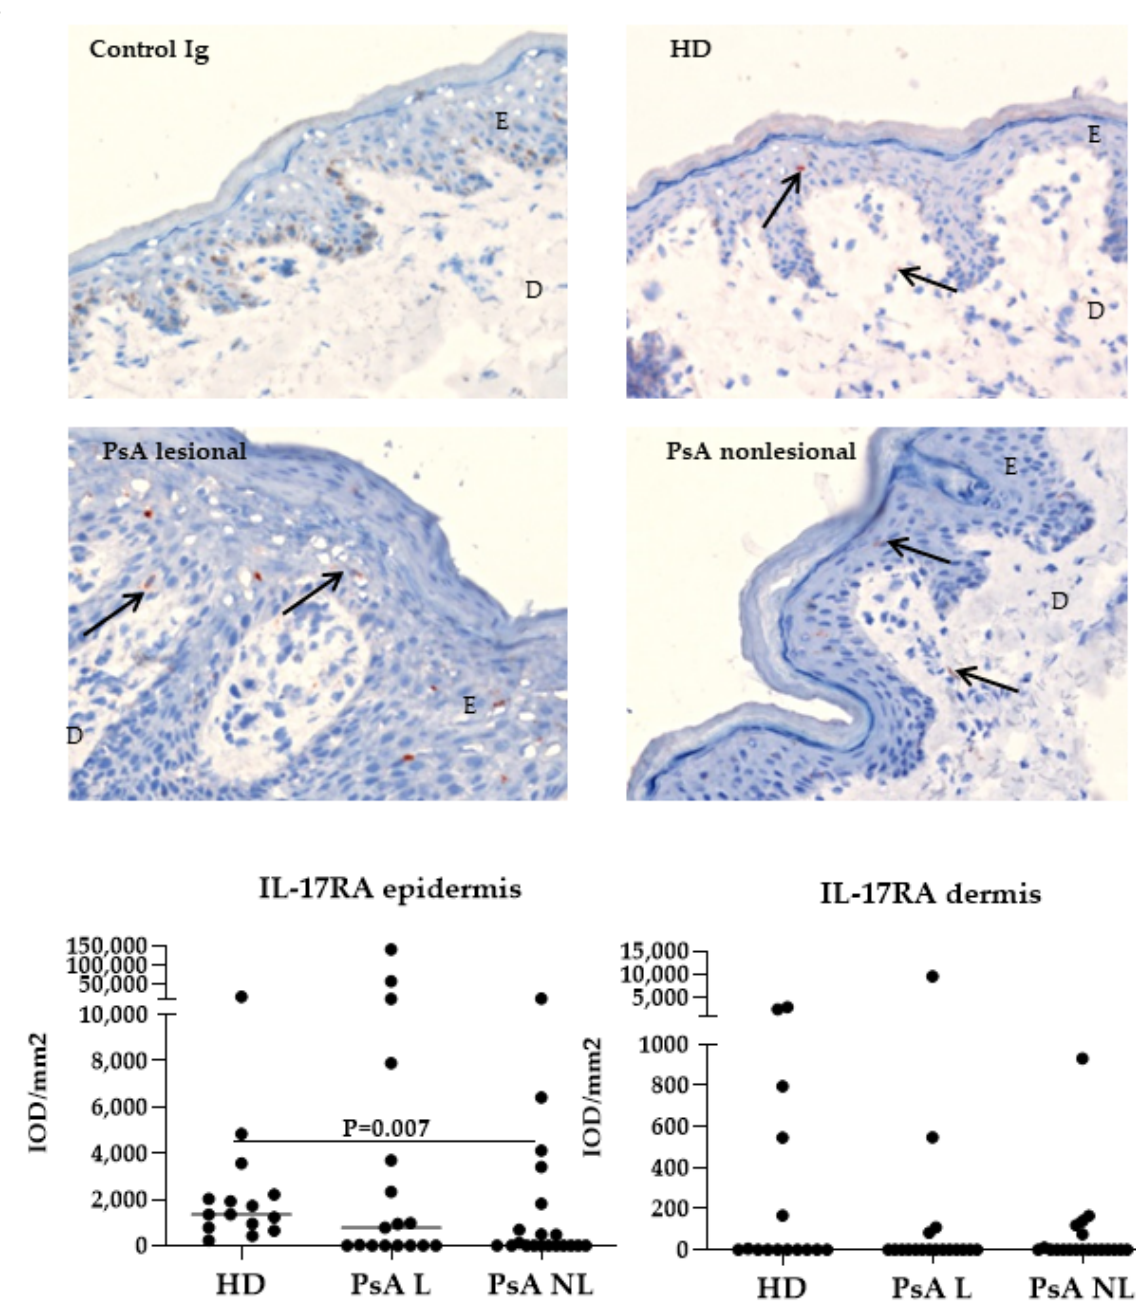
Figure 3. Expression of IL-17RA was lower in the epidermis of the nonlesional psoriatic skin compared to healthy donor skin. ( A ) Representative immunohistochemical staining of baseline IL-17RA expression (arrows) in skin from HD and PsA patients. Original magnification 200 × . ( B ) Quantification of IL-17RA (Kruskal-Wallis test, epidermis p = 0.03, dermis p = 0.007) expression in HD, PsA L skin and PsA NL skin. Results are shown as median IOD/mm 2 and IQR of epidermis and dermis of HD and PsA patients. Per subject the median expression level of 18 high-power fields is used for analysis. p values given in the graphs are calculated from a post Dunn’s test. E, epidermis; D, dermis, IL, interleukin; HD, healthy donor; PsA, psoriatic arthritis; L; lesional, NL; nonlesional, IOD; integrated optical density, IQR; interquartile range.